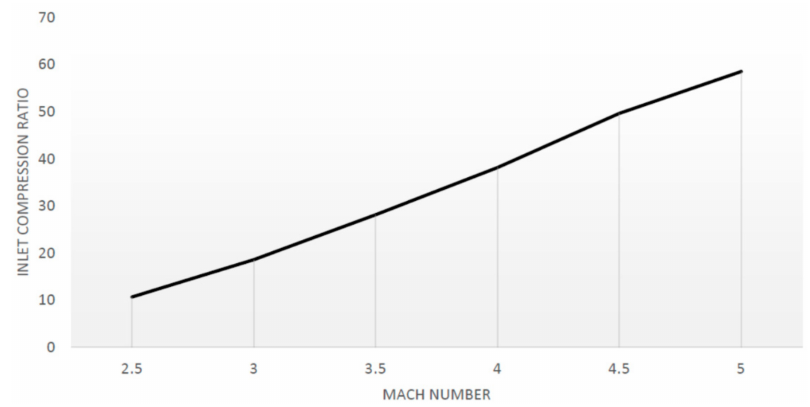
Figure 8. Inlet compression ratio vs. Mach